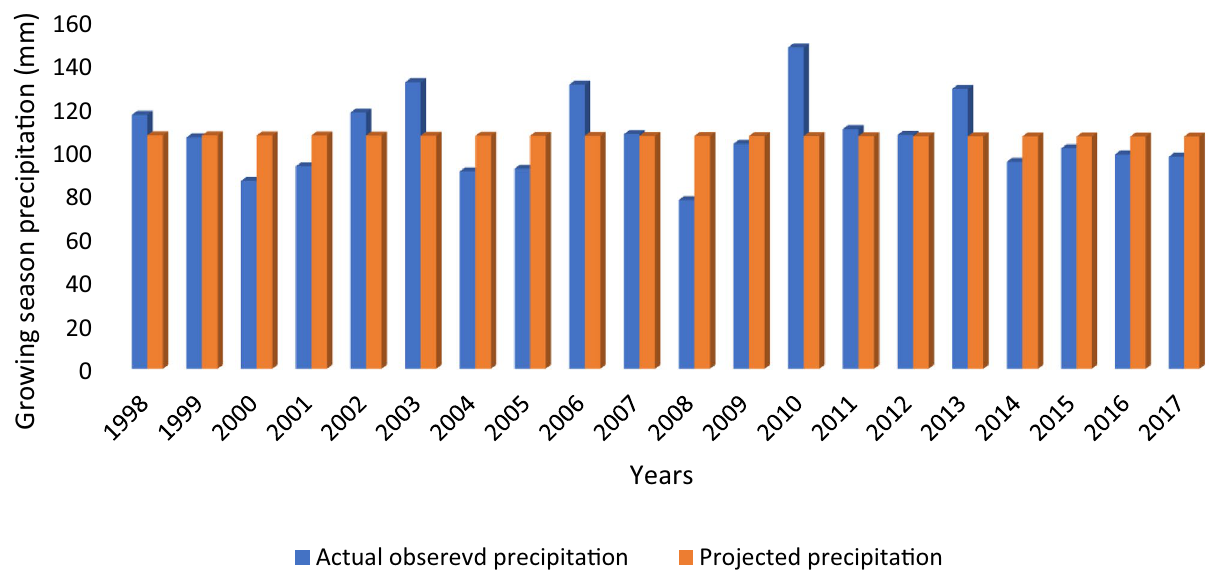
Fig. 6 Actual and projected maize growing season precipitation in Uganda